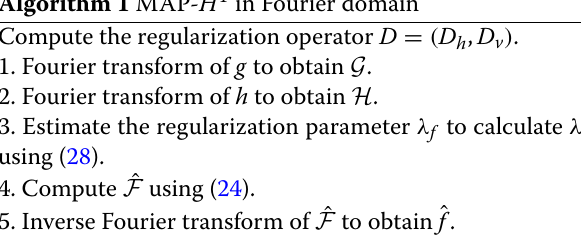
Fig. 1 First kernel of convolution. The first kernel used to blur